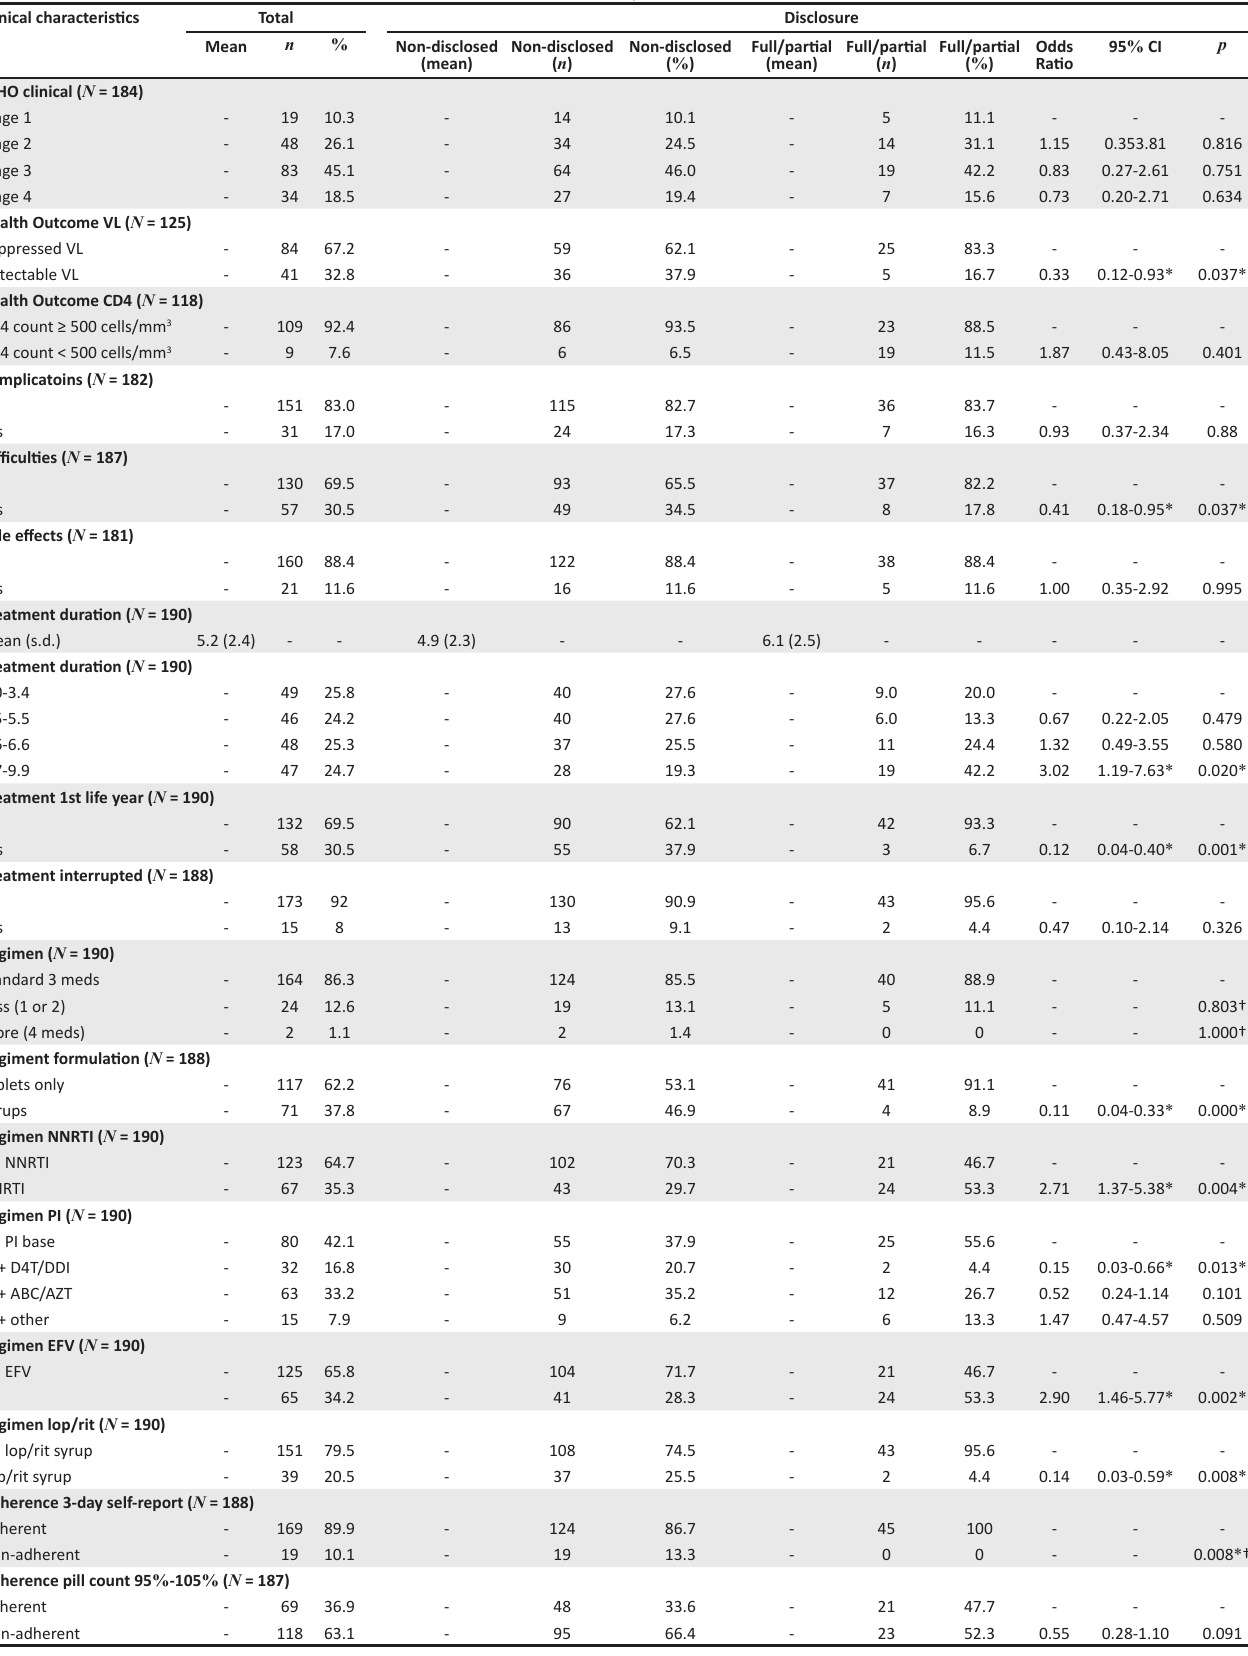
TABLE 3: Associations between disclosure and clinical characteristics – Univariate analyses. Clinical